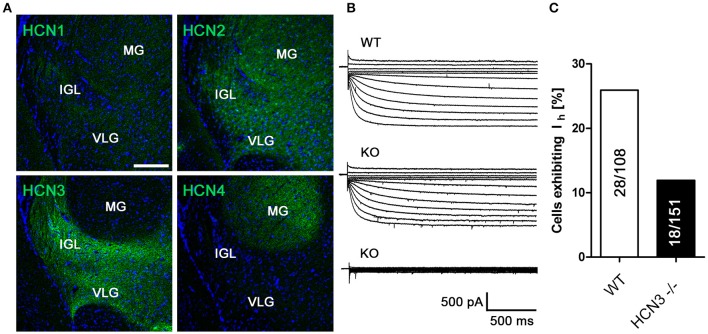
HCN3 channels are expressed in the intergeniculate leaflet and contribute to Ih. (A) Expression of HCN channel subtypes in the intergeniculate leaflet (IGL), medial geniculate nucleus (MG) and ventral geniculate nucleus (VLG); Scale bar, 200 μm. (B) Family of current traces for Ih recordings in acute slice preparations containing the IGL. Upper panel: recordings from WT preparations. In slices prepared from HCN3−/− mice, two populations of cells were present, one containing Ih (middle panel), which is most likely carried by HCN2, and one without Ih (lower panel). (C) Number of tested IGL neurons exhibiting the Ih current in relation to the number of tested cells given in %.